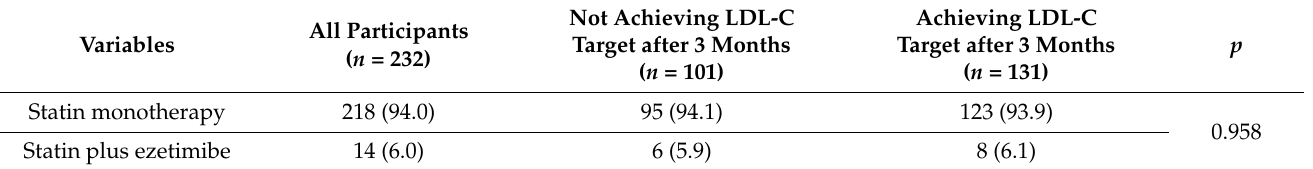
Table 3. Statin use after 3-month follow